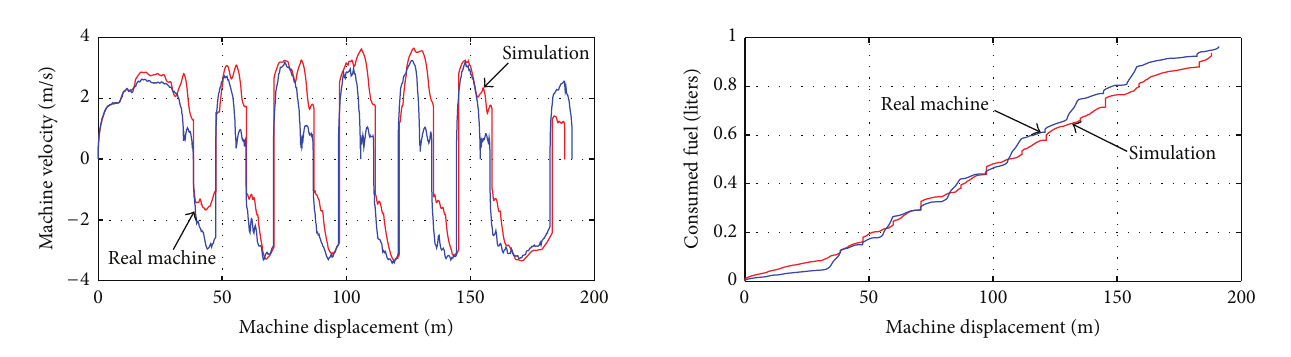
Figure 13: Validation consumed